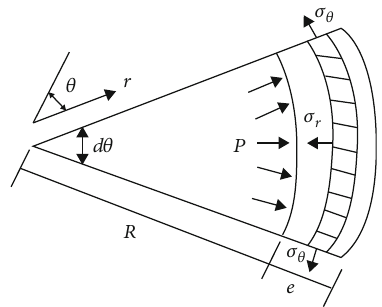
Figure 2: Force diagram of radial section of